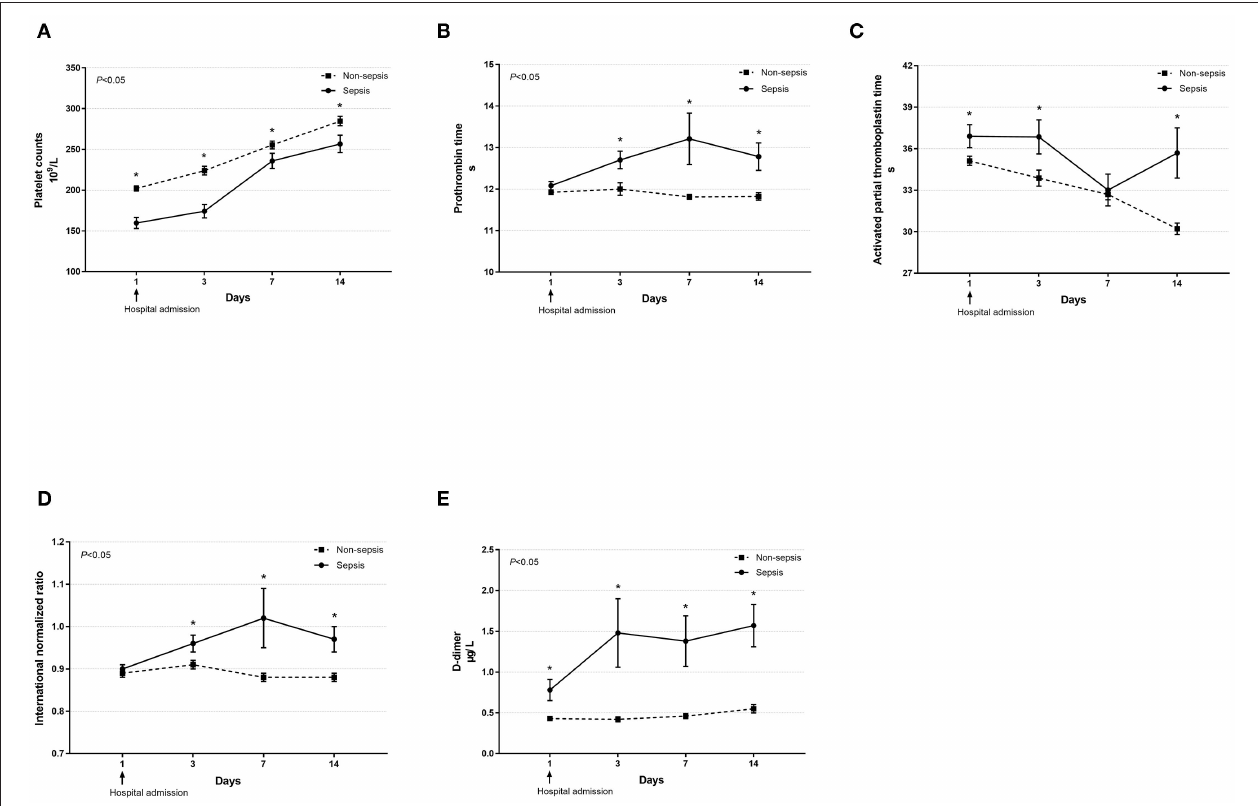
FIGURE 4 | Dynamic profiles of indicators for coagulation function in septic and non-septic COVID-19 patients. Coagulation function, including platelet counts (A) , prothrombin time (B) , activated partial thromboplastin time (C) , international normalized ratio (D) , and D-dimer (E) in septic and non-septic COVID-19 patients were monitored and compared on days 1, 3, 7, and 14 after hospital admission. Data were presented as mean ± SEM. * P < 0.05, septic patients vs. non-septic patients. Results were tested for significance by using a general linear model with corrections for repeated